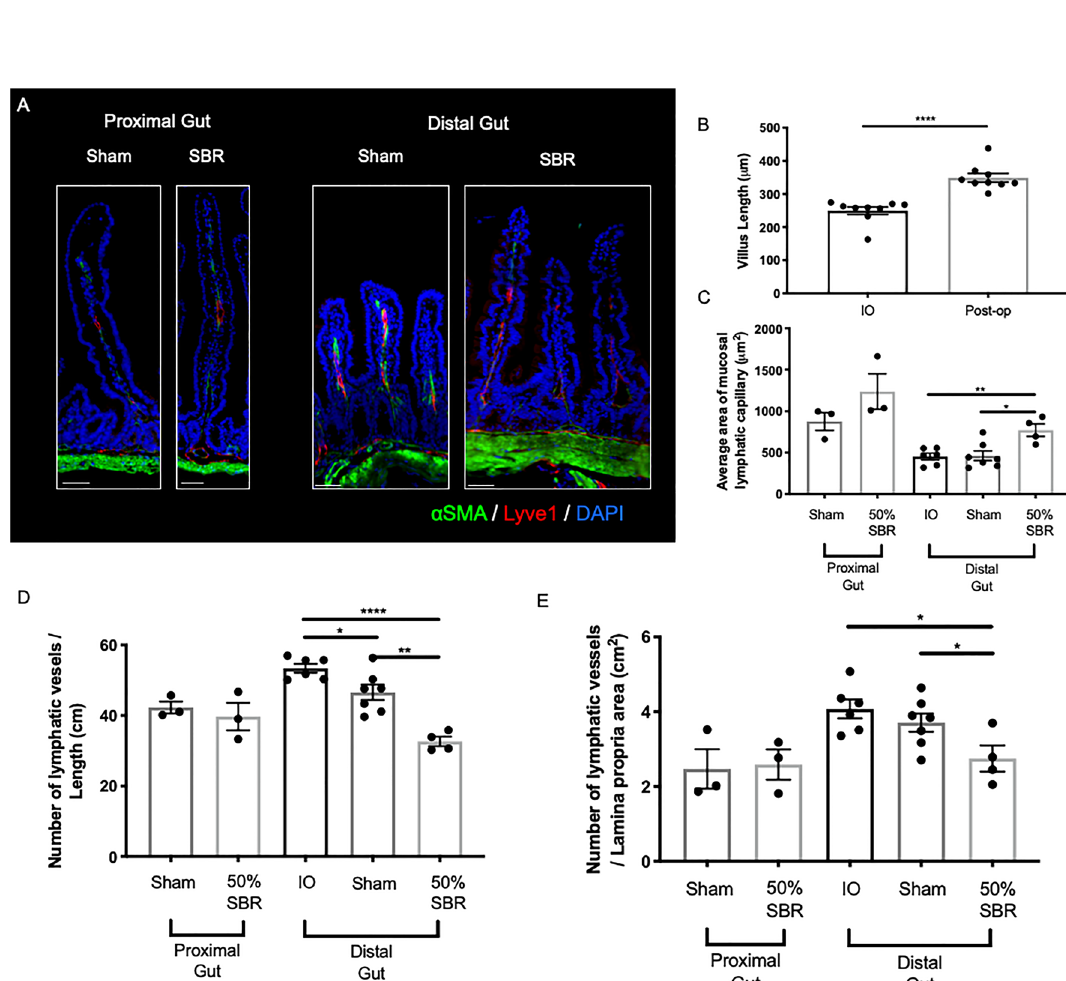
Figure 5. Chronic mucosal lymphatic capillary changes in SBR vs. sham mice. ( A ) Representative immunofluorescence images of proximal (left side) and distal (right side) sham and 50% SBR intestinal tissue sections stained for smooth muscle (alpha-smooth muscle actin, αSMA, green), lymphatics (LYVE-1, red), and nuclei (DAPI, blue) on post-operative week 15 and 12, respectively. Lyve1 + vessels were considered mucosal lymphatics when present in the lamina propria (defined as the space between the basal membrane and muscularis mucosa in αSMA, green). Scale bar 30 μm. ( B ) Villus height increased by an average of 40% in 50% resected mice ( n = 9 for IO and Post-op), assuring adaptation. ( C ) Average area of mucosal lymphatic capillaries in proximal (sham n = 3, 50% SBR n = 3) and distal (intraoperative n = 6, sham n = 7, 50% SBR n = 4) intestine. The number of mucosal lymphatic capillaries (Lyve1 + vessels as in A) per ( D ) length and ( E ) total area of the lamina propria in proximal and distal intestinal tissue. * p < 0.05, ** p < 0.005, **** p <